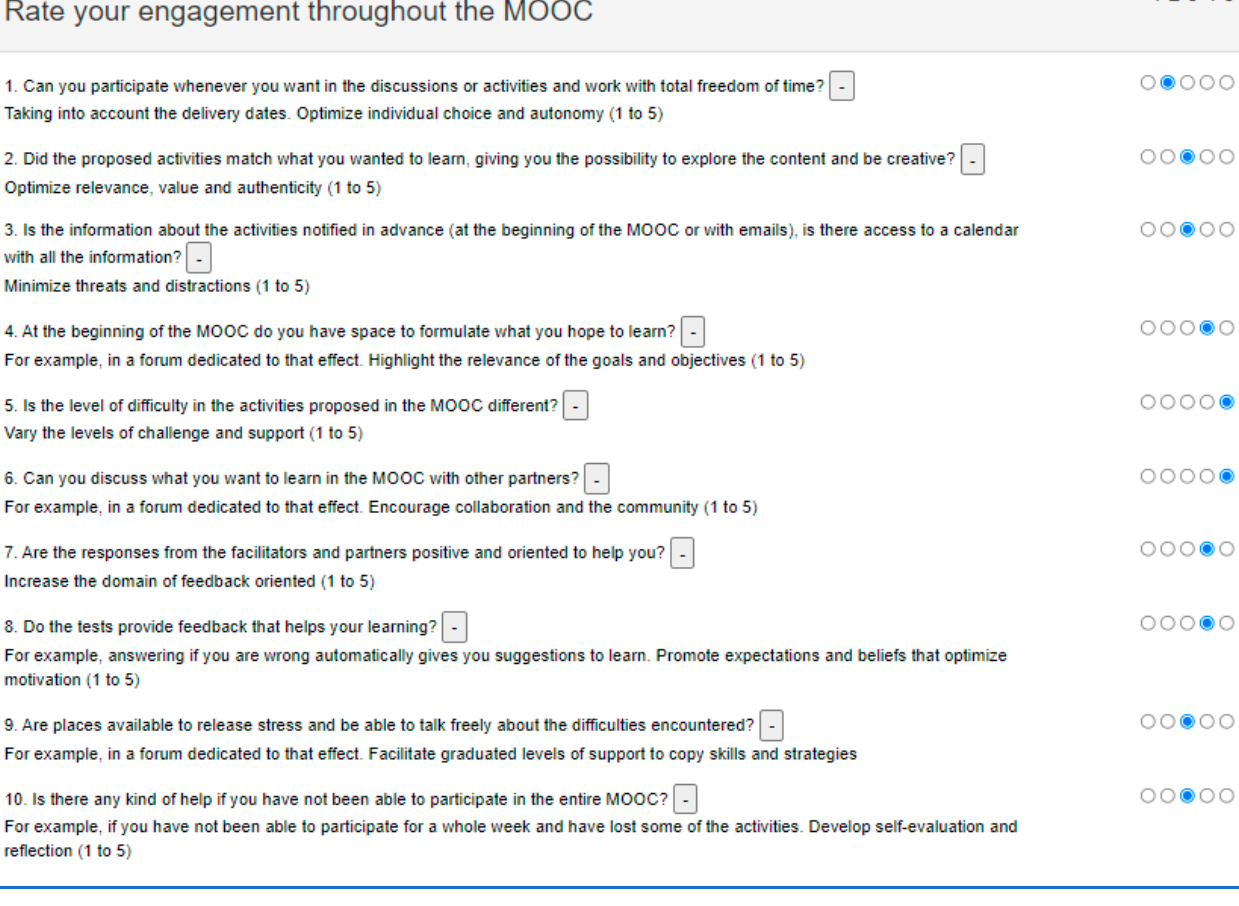
Figure 2. Provide multiple means of engagement